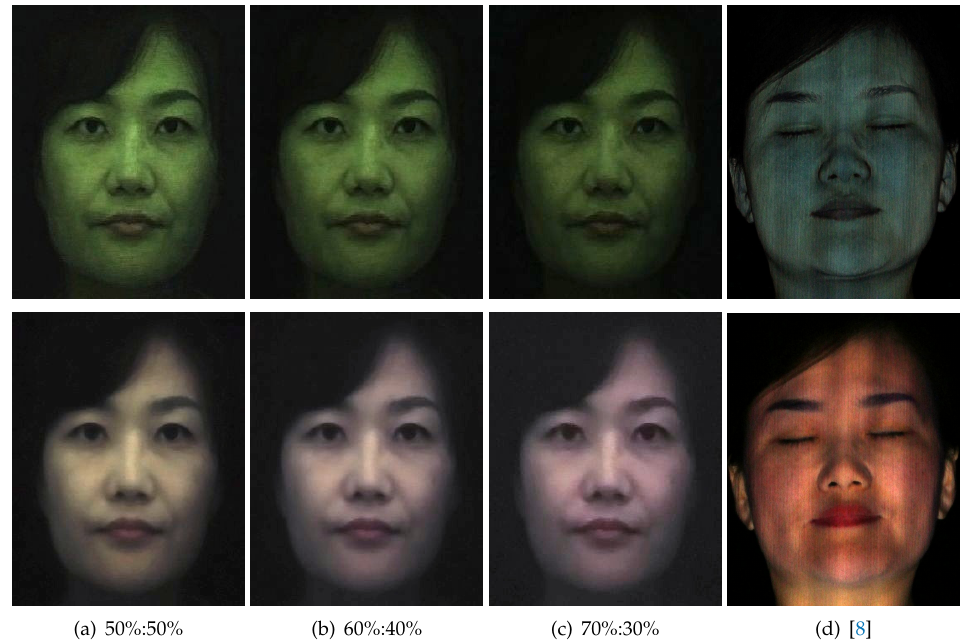
Figure 13. Comparison of shallow and deep separation with single-shot TPLF imaging and the multi-shot technique of Ghosh et al. [8]. ( a – c ) Different split ratios of intensity averaging (brighter (shallow + deep)%:darker (deep)%) with TPLF imaging. ( d ) Separation with phase-shifted structured lighting patterns.